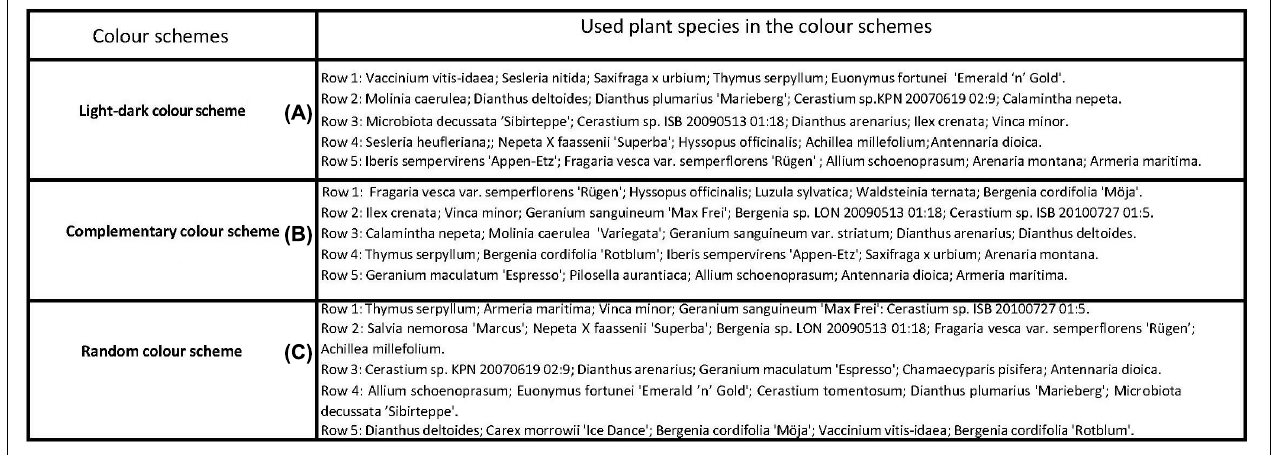
FIGURE 4 | The species used to create a design based on light-dark design and complementary design and one random design for a theoretical living